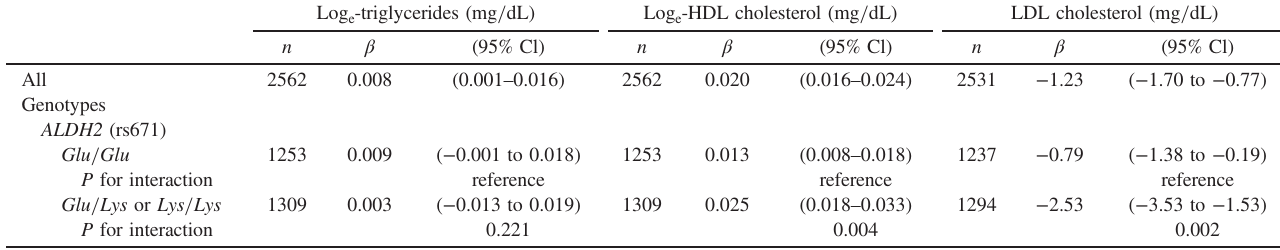
Table 5. Increase in serum lipid levels with an increase of alcohol intake by 10g / day according to the genotypes of ALDH2 in the replication study